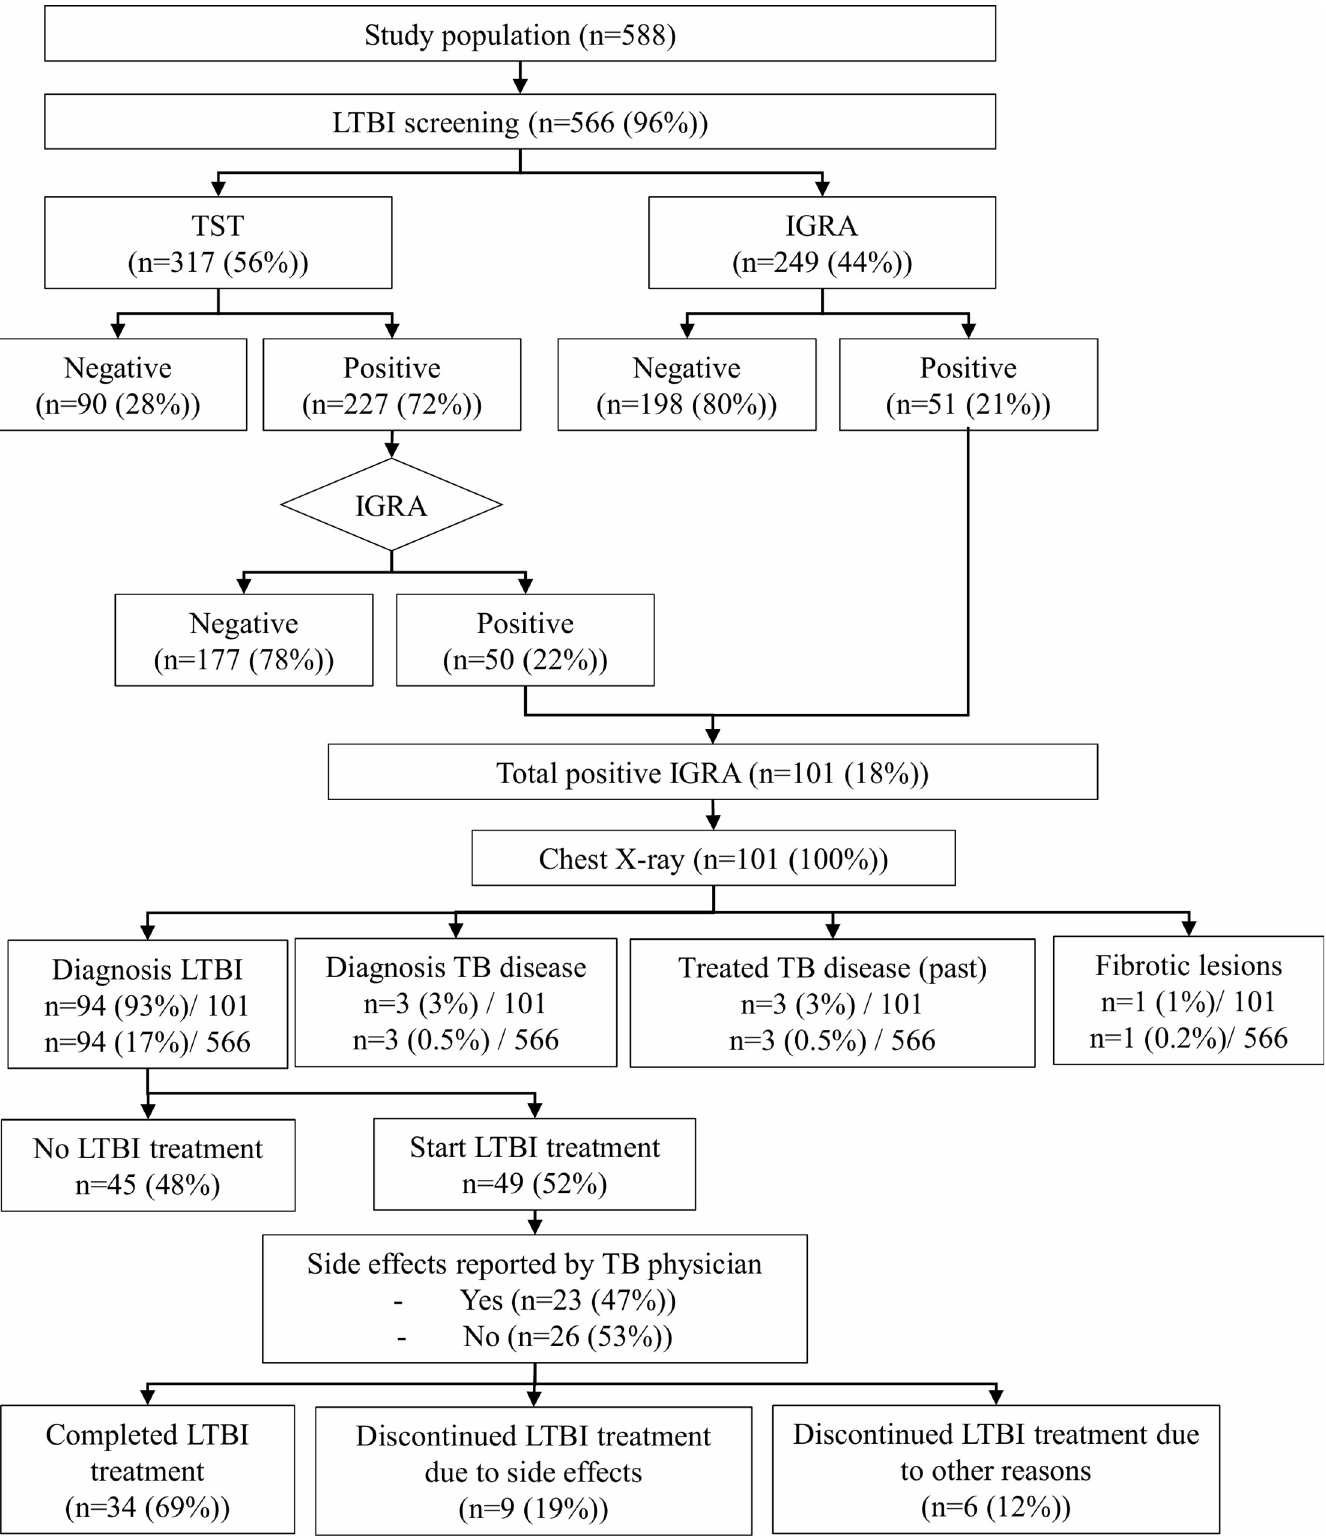
Fig 1. Flowchart of latent tuberculosis infection screening and treatment results.